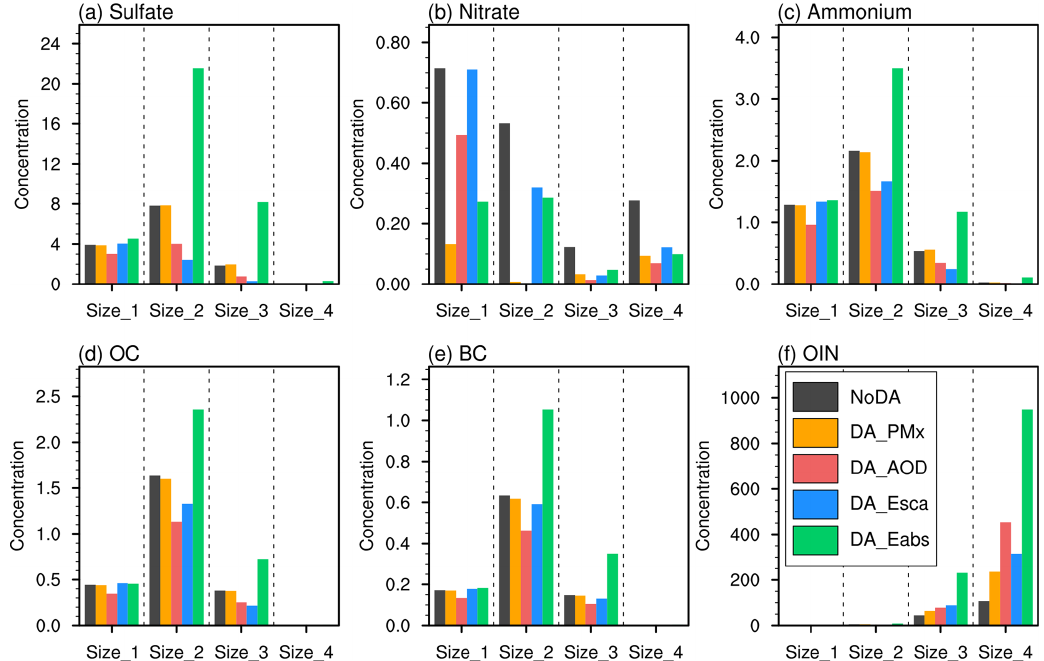
Figure 8. Mean aerosol concentrations (µgm − 3 ) per size bin in the background (NoDA) and the DA analyses when assimilating each individual observation at Kashi in April 2019.